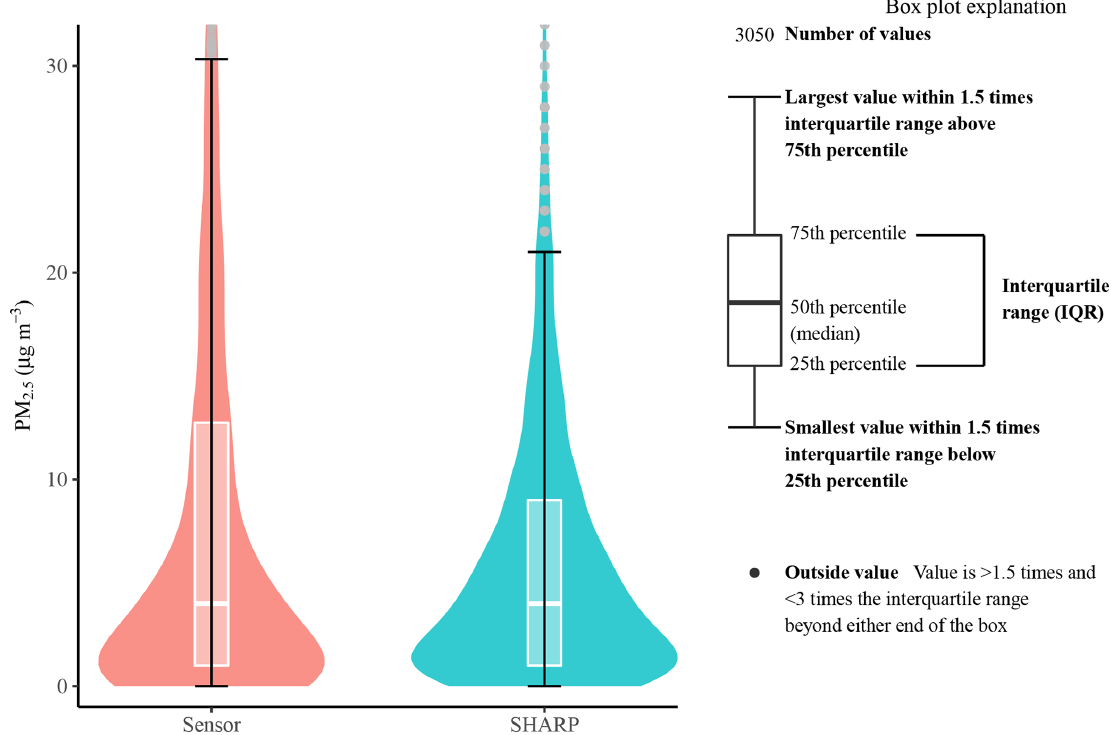
Figure 4. Comparison of the hourly PM 2 . 5 values between the low-cost PM sensor and SHARP. Based on 3050 hourly paired data points. The low-cost sensor has 250 hourly data points greater than 30µgm − 3 . SHARP has 174 hourly data points greater than 20µgm − 3 . Bars indicate the 25th and 75th percentile values, whiskers extend to values within 1.5 times the interquartile range (IQR), and dots represent values outside the IQR. The box plot explanation on the right is adjusted from DeCicco